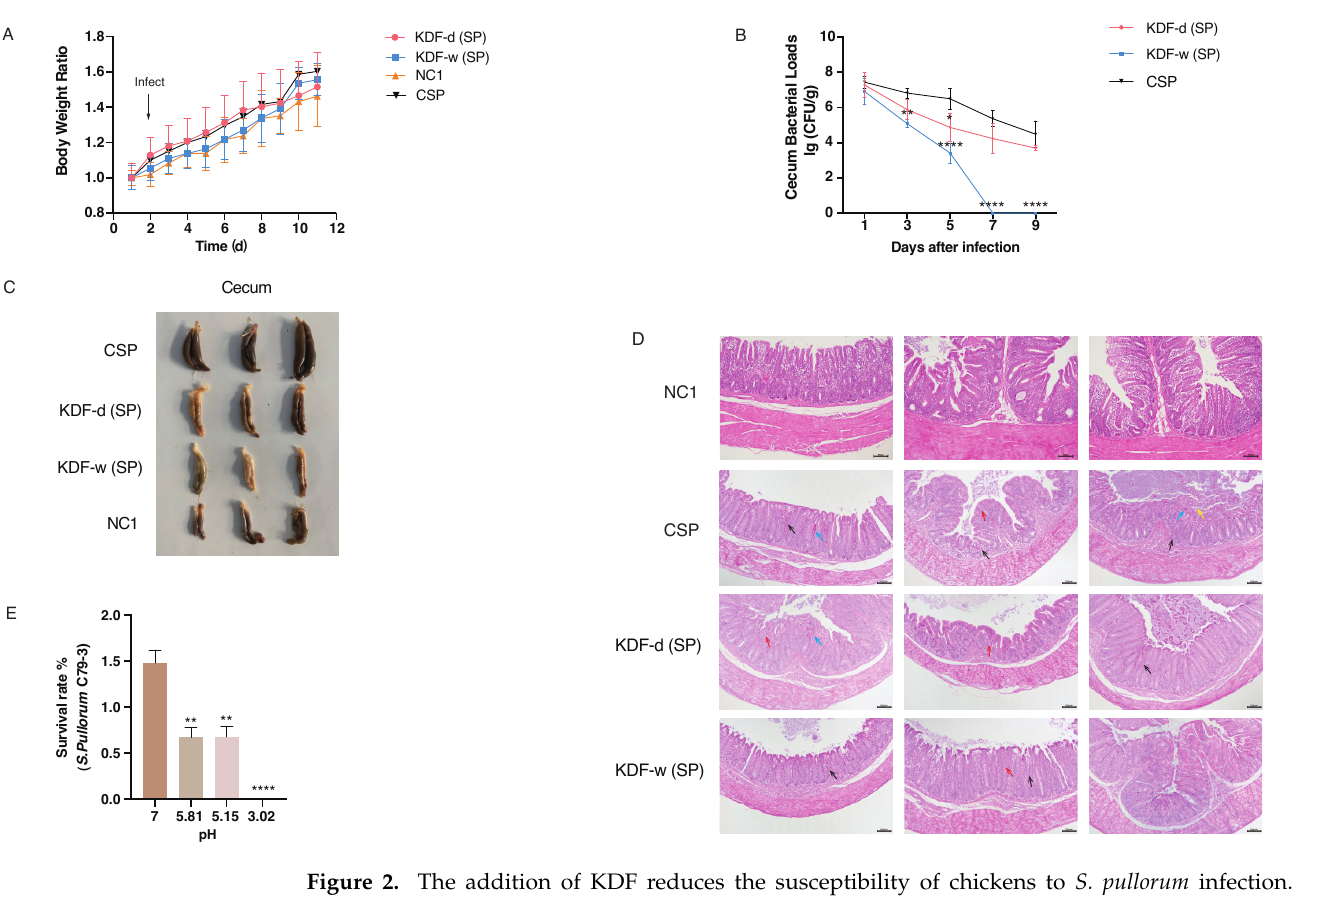
Figure 2. The addition of KDF reduces the susceptibility of chickens to S. pullorum infection. ( A ) Changes in body weight of the chickens. ( B ) S. pullorum loads in the cecum (n = 6). ( C ) Ce- cum morphology of chickens (n = 3). ( D ) Pathological changes in the cecum of chickens in different groups (n = 3). Black arrow: inflammatory cell infiltration; red arrow: decrease in goblet cells in the mucosal layer; blue arrow: congestion of the interstitial blood vessels; yellow arrow: mucosal epithelial cell necrosis and nuclei pyknosis, dissolution and disappearance. ( E ) Survival rate of S. pullorum C79-3 at different pH values (n = 3). KDF-d (SP): chickens supplied with 0.5% KDF in diet infected with S. pullorum ; KDF-w (SP): chickens supplied with 0.1% KDF in drinking water infected with S. pullorum ; CSP: chickens supplied with non-supplemented diet and water infected with S. pullorum ; NC1: chickens supplied with non-supplemented diet and water without infection. All data are shown as means ± SD. * p < 0.05, ** p < 0.01, **** p < 0.0001. Table 1. The pH values in different GIT segments of inoculated chickens receiving no KDF or KDF supplementation in diet or water.